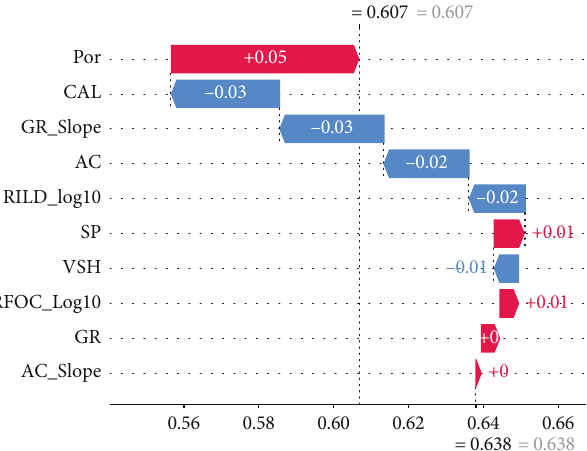
Figure 9: The waterfall plot for an individual case of sample no. 20.